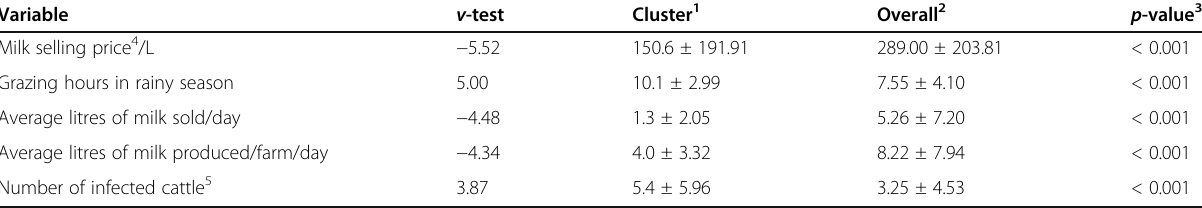
Table 2 Top 5 relevant quantitative variables that best describe the 40 farms from cluster 1. Overall sample = 100 farms Variable